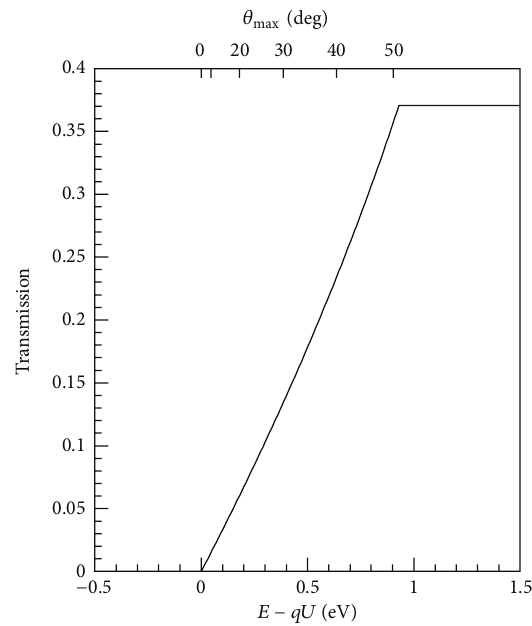
Figure 9: Transmission function of the KATRIN experiment as a functionofthesurplusenergy 𝐸−𝑞𝑈 accordingto(41).TheKATRIN default design settings [72] were used as follows: 𝐵 min = 3 ⋅ 10 −4 T, = 6 T, 𝐵 = 3.6 T. The upper horizontal axis illustrates 𝐵 max S , which is the dependence of the maximum starting angle 𝜃 S , max transmitted at a given surplus energy. Clearly, electrons with larger ≤ 𝜃 reach the transmission condition later, starting angles 𝜃 S S , max since they still have a significant amount of cyclotron energy in the analyzing plane at 𝐵 min